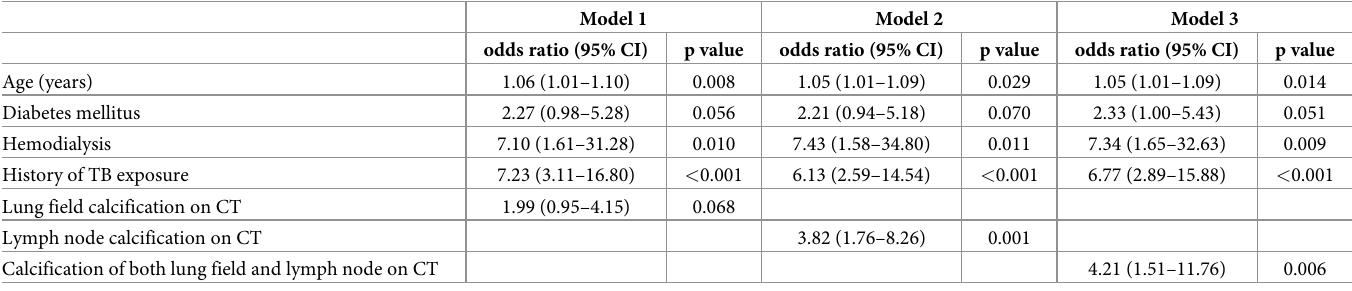
Table 3. Multivariate analysis of the baseline characteristics and chest radiological features associated with positive IGRA